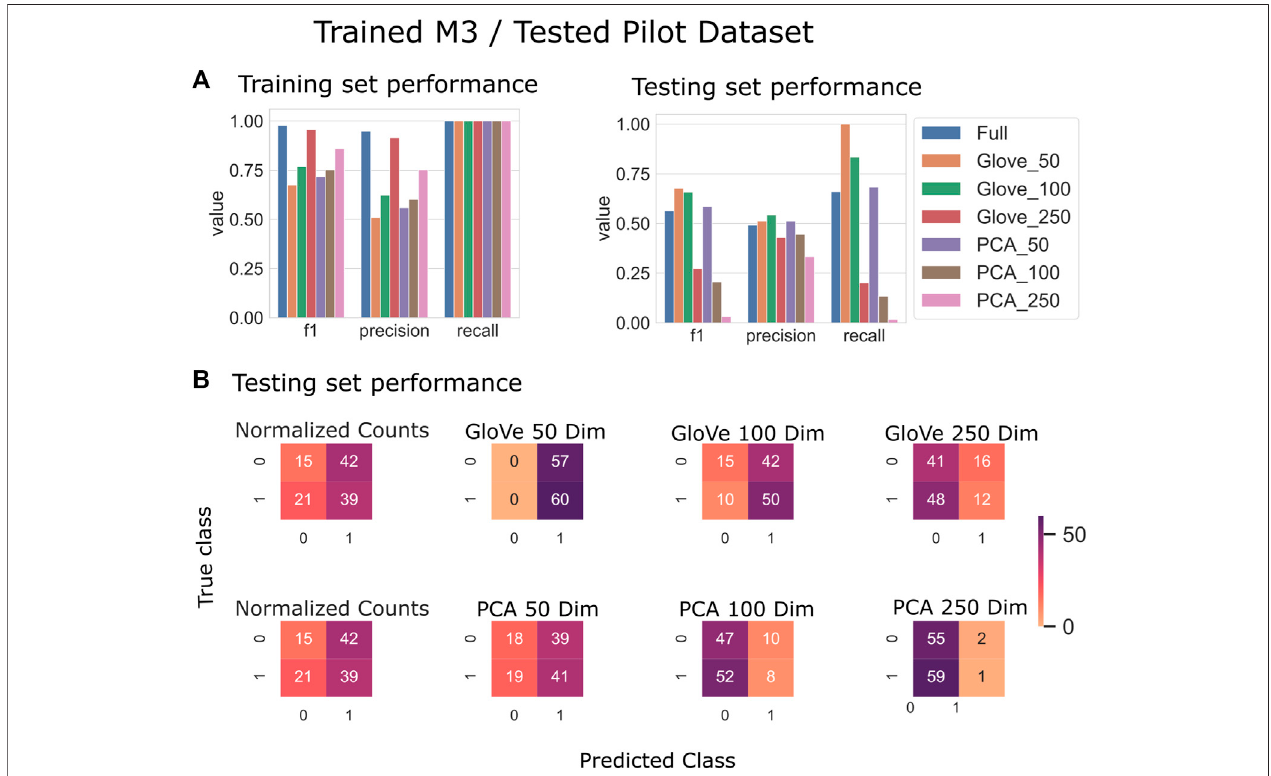
FIGURE 4 | Predicting autism spectrum disorder: Model trained on the M3 dataset and tested on the Pilot dataset. (A) : Models built using GloVe embedded data, PCAembeddeddata(50,100,or250dimensions),ornormalizedASVcountsperformanceontrainingandtestingsets. (B) :Confusionmatricesshowingthedistribution of correct to predicted classes on the testing